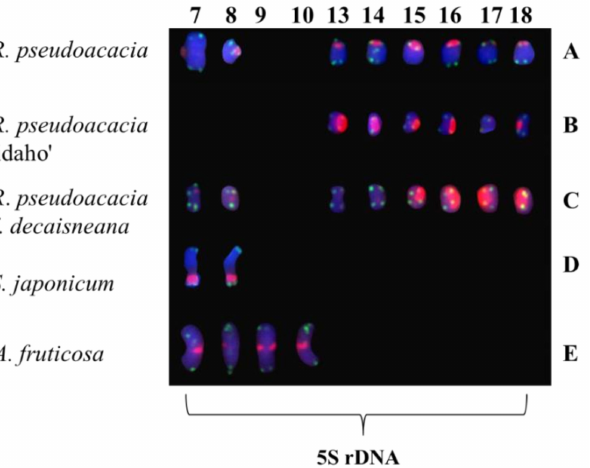
Figure 4. Chromosomes of five Fabaceae identified using 5S rDNA cut Figure 1. ( A ) R. pseudoacacia , ( B ) R. pseudoacacia ‘idaho’, ( C ) R. pseudoacacia f. decaisneana . ( D ) S. japonicum , and ( E ) A. fruticose . The numbers on the upper side represent the chromosome number consistent in Figure 1. Figure 4 is